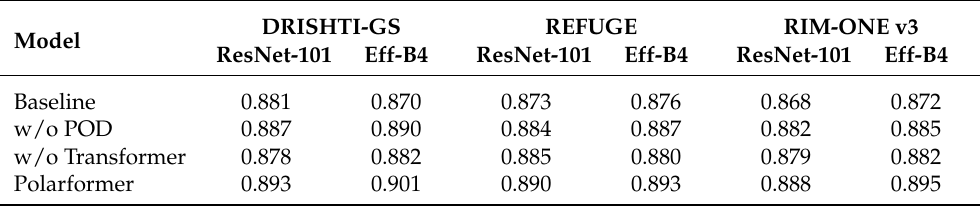
Table 2. Ablation study on every module of our proposed method on the DRISHTI-GS dataset, RIM-ONE v3 dataset and REFUGE dataset.